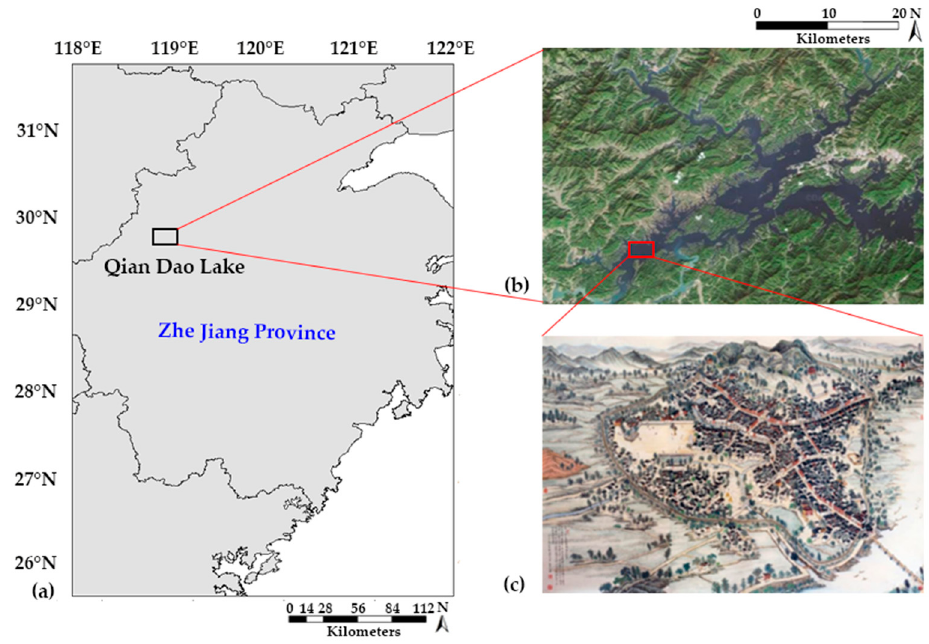
Figure 2. ( a ) Location of Qiandao Lake. ( b ) Satellite image of Qiandao Lake. ( c ) Picture painted to restore the original appearance of the town.